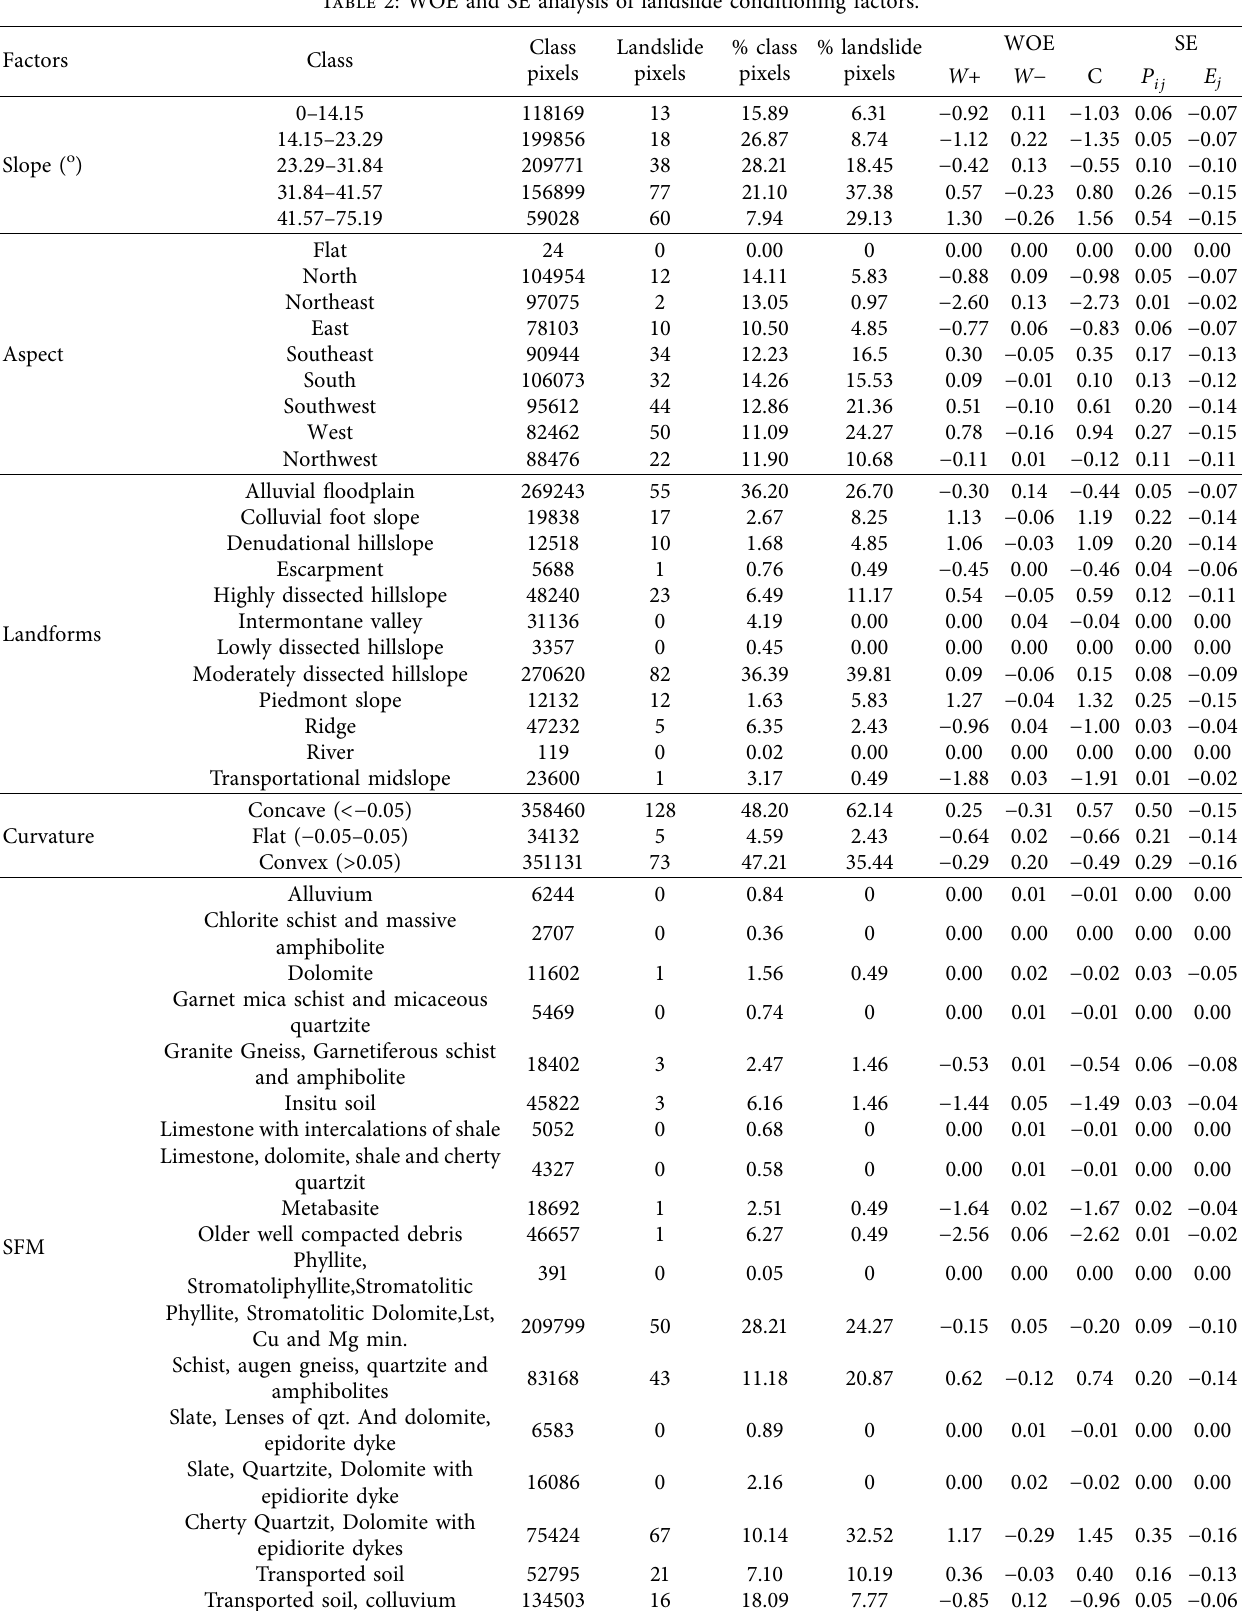
Table 2: WOE and SE analysis of landslide conditioning